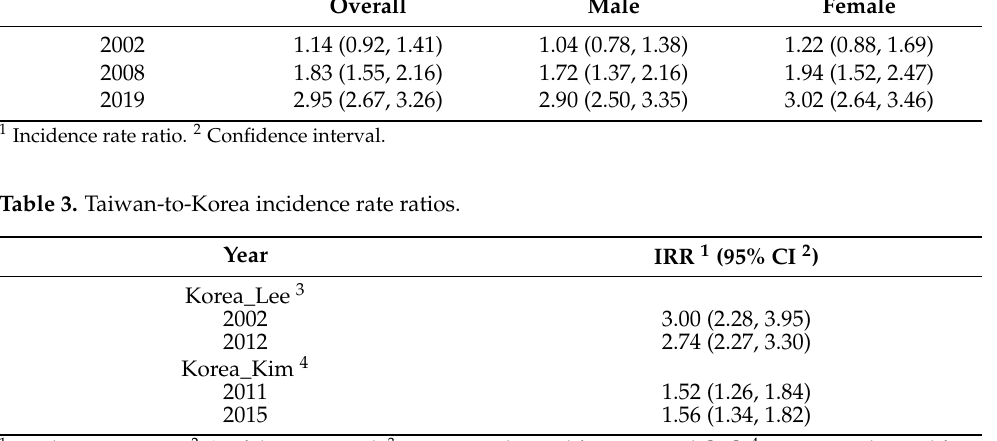
obtained from Kim et al. [2].